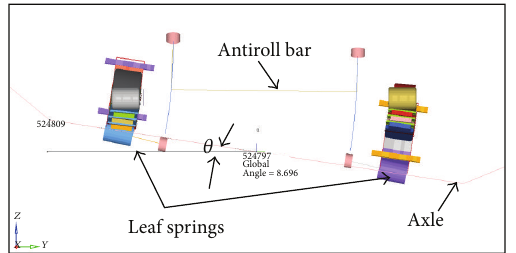
Figure 8: Roll angle measurement of suspension